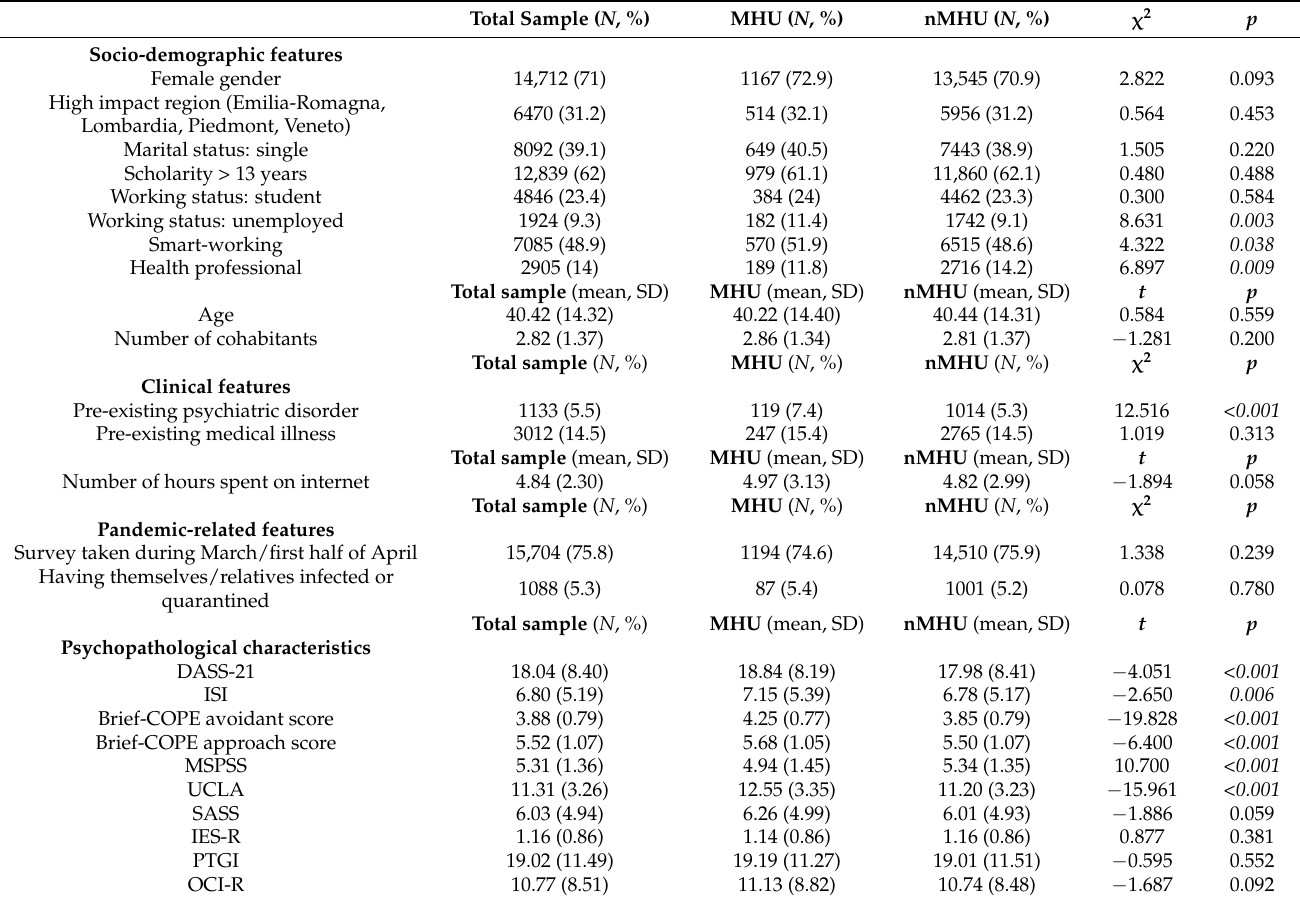
Table 2. Comparison of socio-demographic, clinical and psychopathological characteristics of subjects who attended a psychiatric or psychological visit (mental health users, MHU, N = 1601, 7.7%) during the first COVID-19 pandemic wave and those who did not.